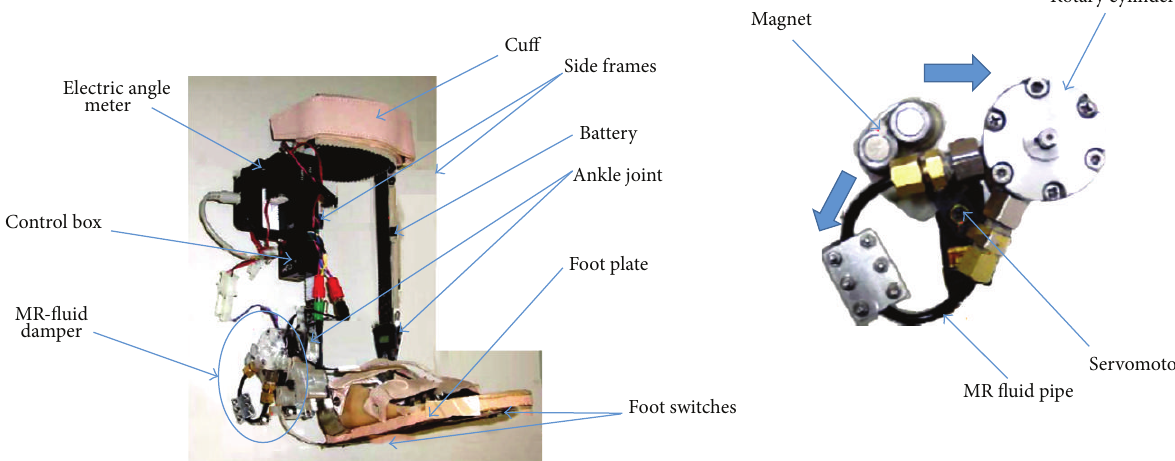
Figure 6: The intelligent AFO with MR fluid damper